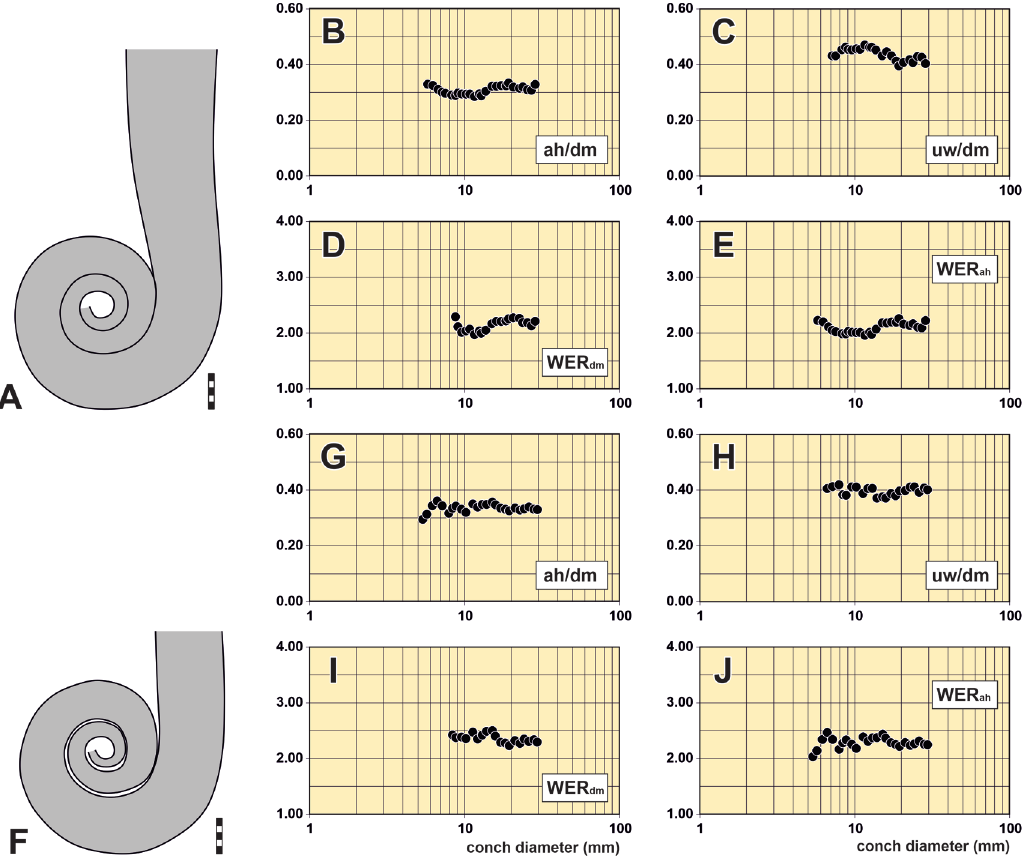
Fig. 48. Lituites procerus Remelé, 1890. A . Outline of coiled conch part of specimen MB.C.30547. B–E . Conch proportions and coiling rates of specimen MB.C.30547. F . Outline of coiled conch part of specimen MB.C.2498. G–J . Conch proportions and coiling rates of specimen MB.C.2498. Scale bar units = 1